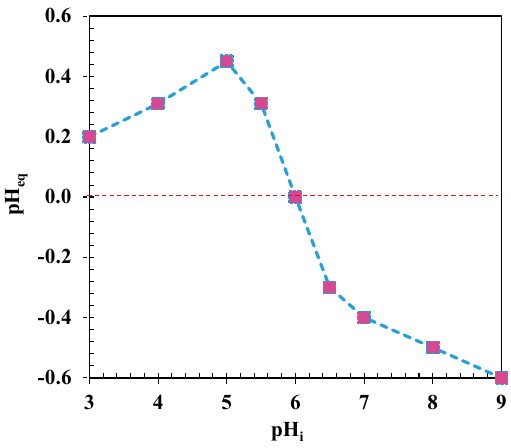
Figure 10. Point of zero charge ZrO 2 /TiO 2 /Fe 3 O 4 photocatalyst.